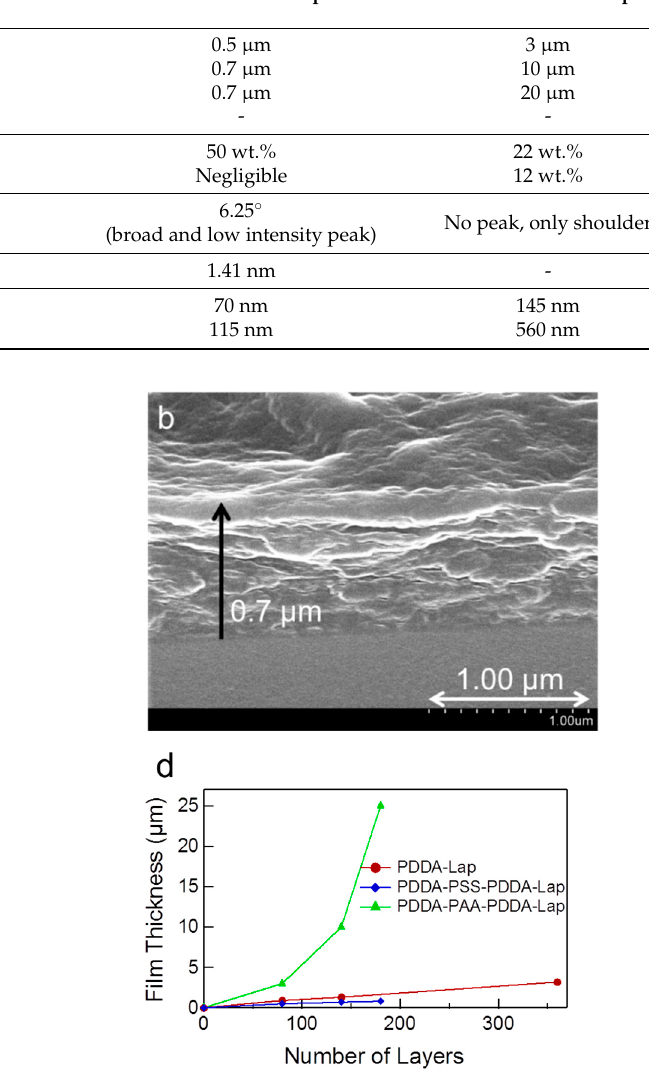
Figure 2. TGA thermograms of laponite powder and multilayers of PDDA-Laponite (360 layers), PDDA-PSS-PDDA-Laponite (180 layers), and PDDA-PAA-PDDA-Laponite (180 layers). Layer Spacing: The layer spacing can be understood by the clay platelet arrangement with respect to each other. Figure 3 compares the XRD patterns of all three systems. The